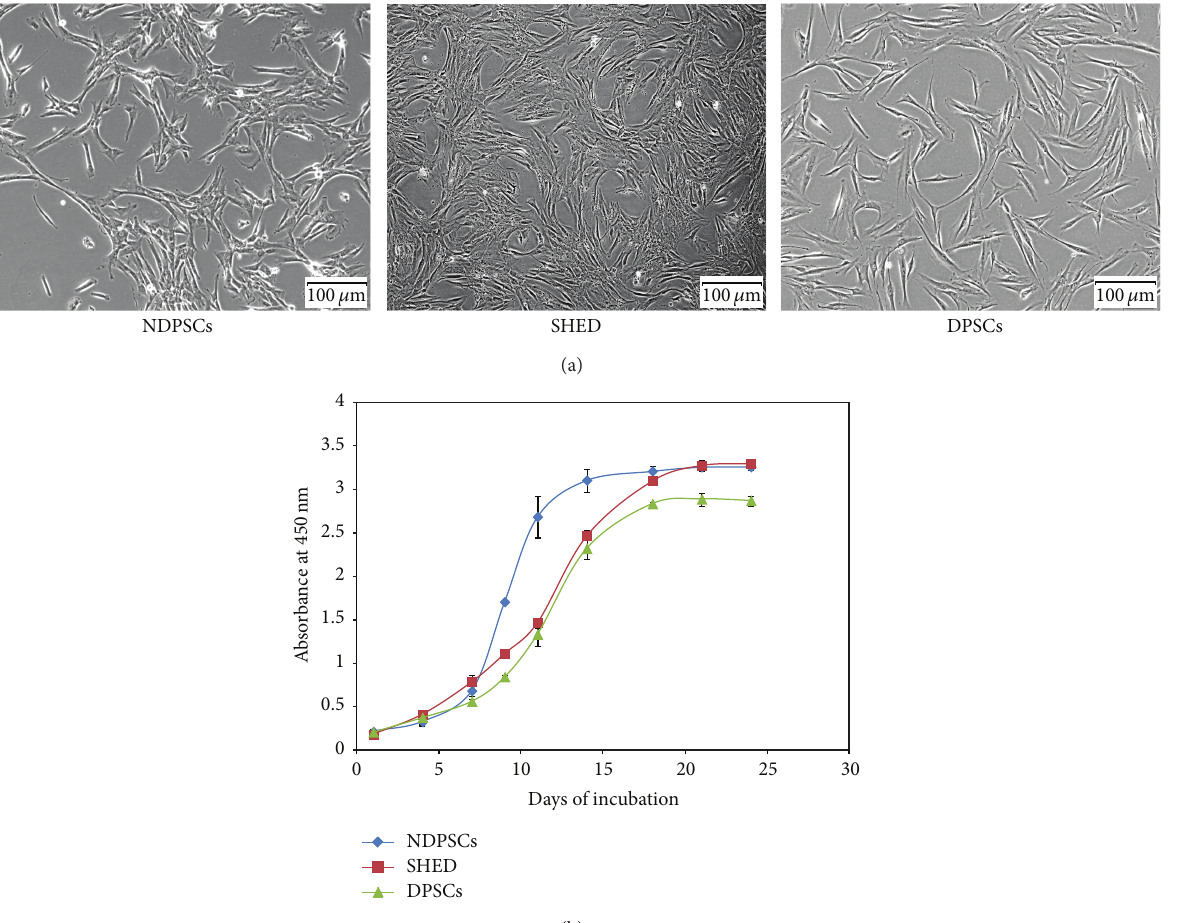
Figure 1: Illustration of MSC morphologies and relevant growth kinetics. (a) Morphology of NDPSCs, SHED, and DPSCs. The cells were at passage three. Images were taken with an inverted microscope (40X). (b) Growth curves for NDPSCs, SHED, and DPSCs over a period of 25 days. The cells were cultured in 96-well plates in triplicate and their growth rates were followed by WST-1 assay, which measures cell viability. DPSCs displayed relatively lower growth rate than SHED and